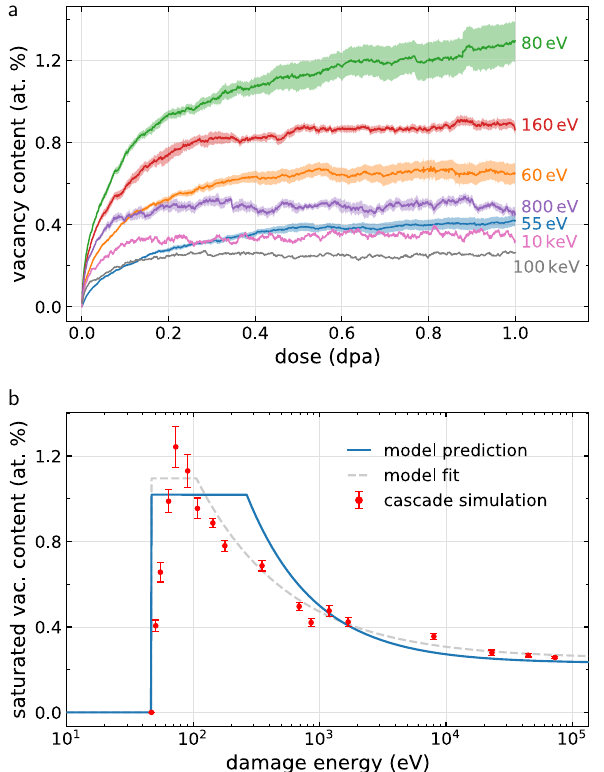
Figure 4. Vacancy content as a function of recoil energy. ( a ) The vacancy concentration in tungsten irradiated up to a dose of 1 dpa, as obtained from cascade simulations, is found to decrease with increasing recoil energy. Shaded areas indicate the standard error obtained from multiple simulations. ( b ) Comparison of the vacancy concentration from simulation in the ∼ 1 dpa high dose limit (points) with the analytic prediction (line) given by the number density of vacancies generated in a cascade in an initially pristine crystal. Fitting the model improves quantitative agreement (dashed), but removes the predictive aspect of the model. Mean values are averaged over 0.9–1.0 dpa, with error bars showing the standard deviation, or in the case of multiple simulations, the mean standard error, over the same